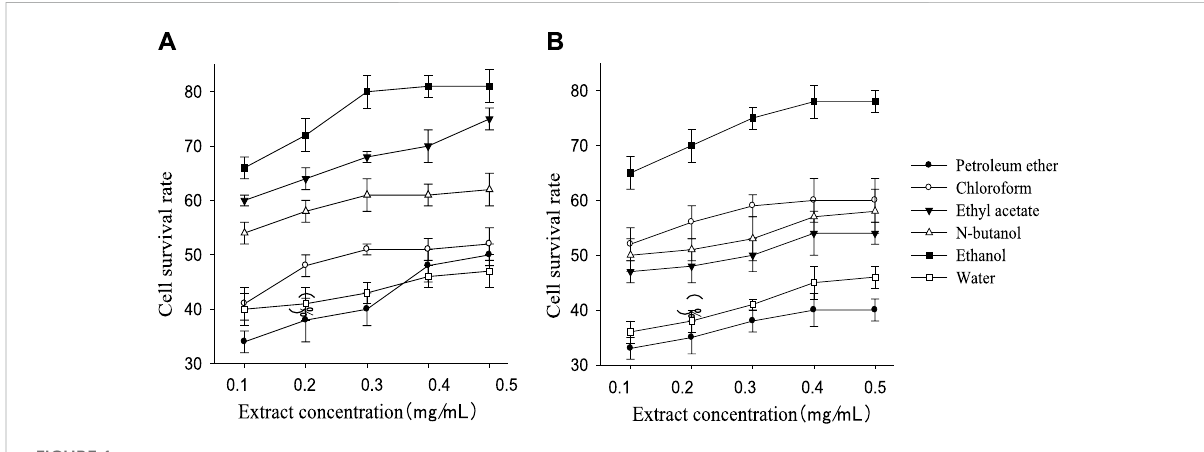
FIGURE 1 Survival rate of nerve cells in different polarity parts of extract of G. biloba leaf (A) and Z. of fi cinale rhizome (B) at different